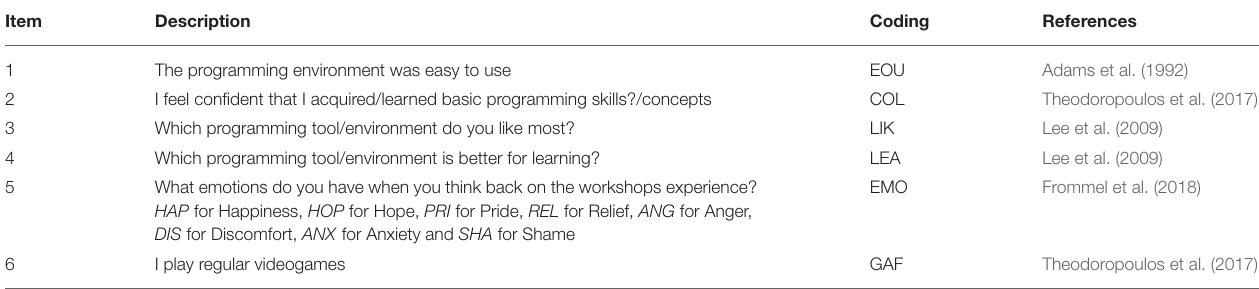
TABLE 3 | Post-questionnaire